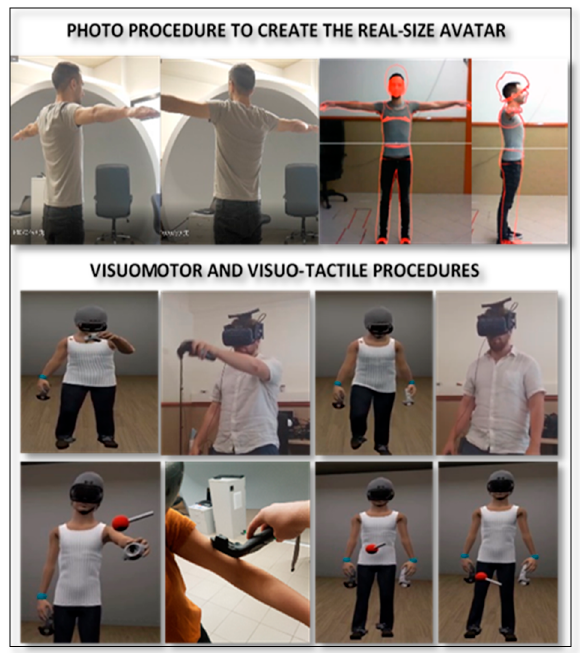
Figure 2. Illustration of the procedures used to induce full-body illusion in the study.